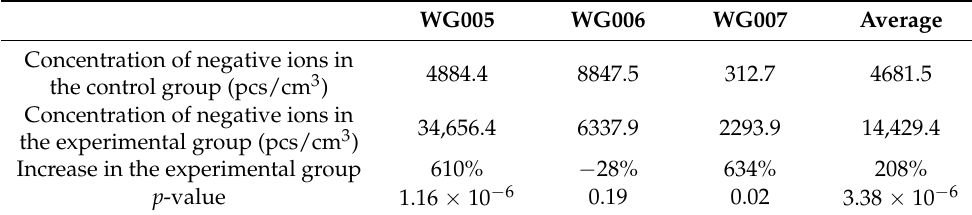
Table 12. Comparison of particle counts by the station in Liupan